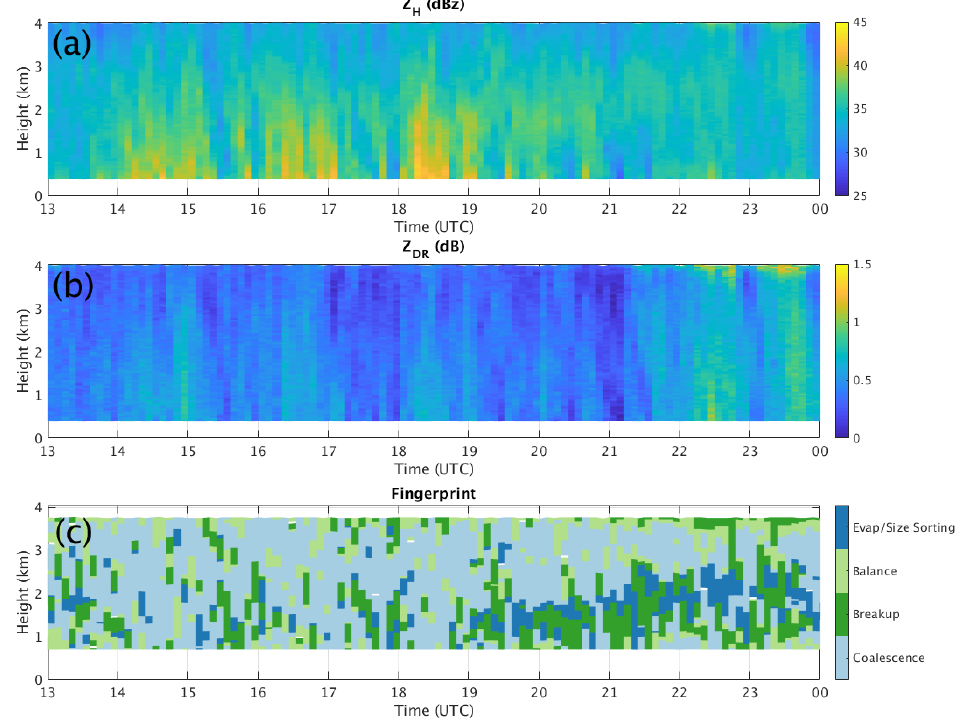
Figure 5. The evolution of vertical profiles of precipitation during Hurricane Matthew on 8 October 2016, observed by the WSR-88D radar near Raleigh, North Carolina (KRAX). ( a ) Time series of quasi- vertical profiles of Z H (in dBz, shaded according to scale); ( b ) time series of quasi-vertical profiles of Z DR (in dB, shaded according to scale); ( c ) retrieval of the dominant microphysical fingerprint in rain (see text for details), where light blue indicates coalescence, dark green indicates breakup, light green indicates the coalescence-breakup balance, and dark blue indicates evaporation or size sorting.